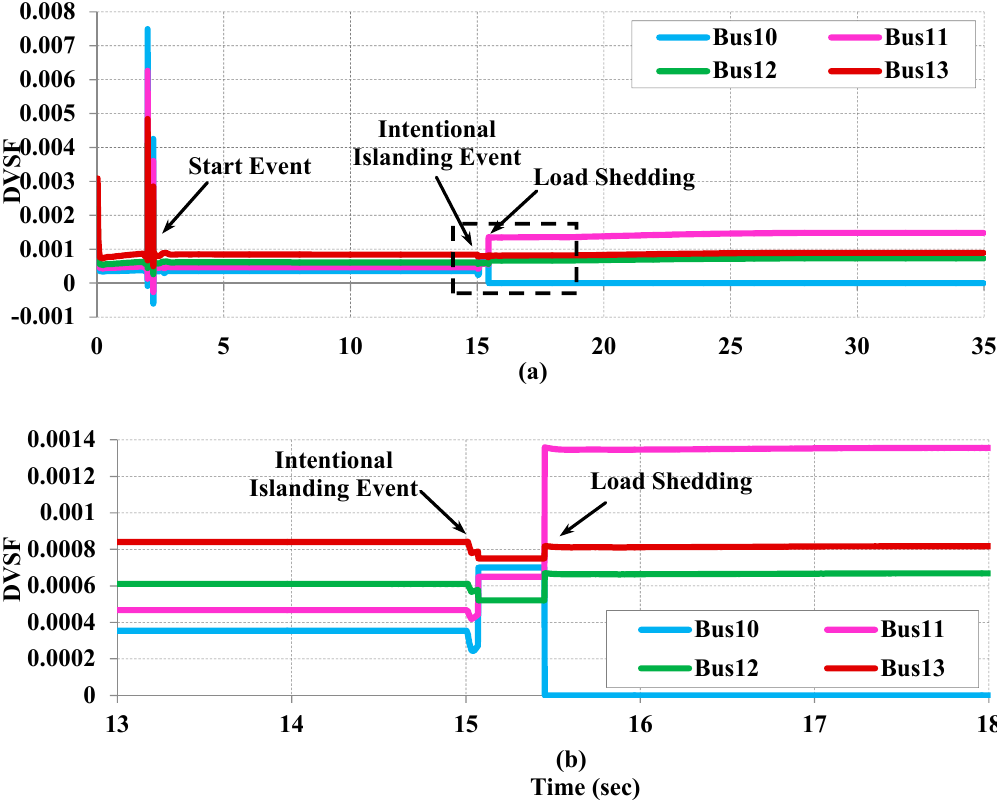
Figure 16. Dynamic voltage sensitivity factor ( a ) full window of DVSF for bus-bars in the island-2, ( b ) Expanded window for DVSF during ‘intentional islanding event’ and ‘load shedding’.